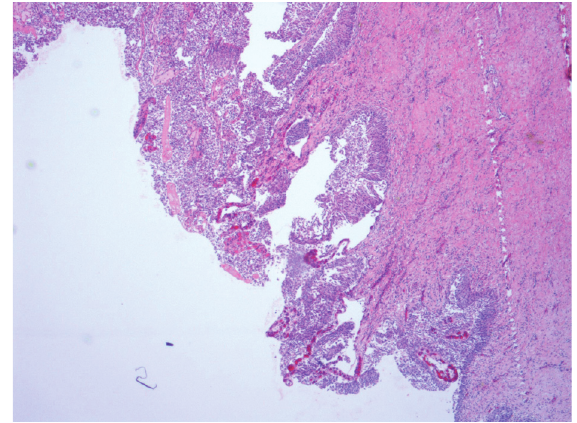
Figure 4. Low power view (×4 objective lens) of Hematoxylin and Eosin (H and E) stained bladder resection specimen showing the superficial component of LNVUC.